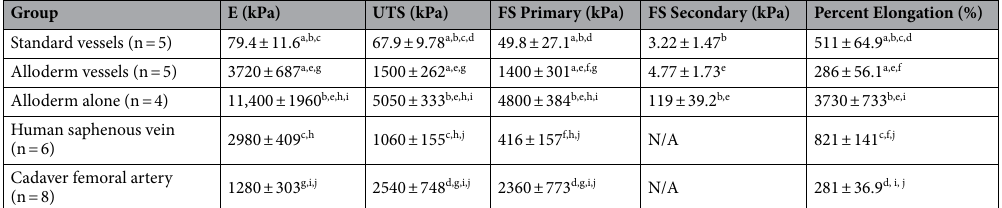
Table 2. Average circumferential vessel material properties. a Statistically significant difference